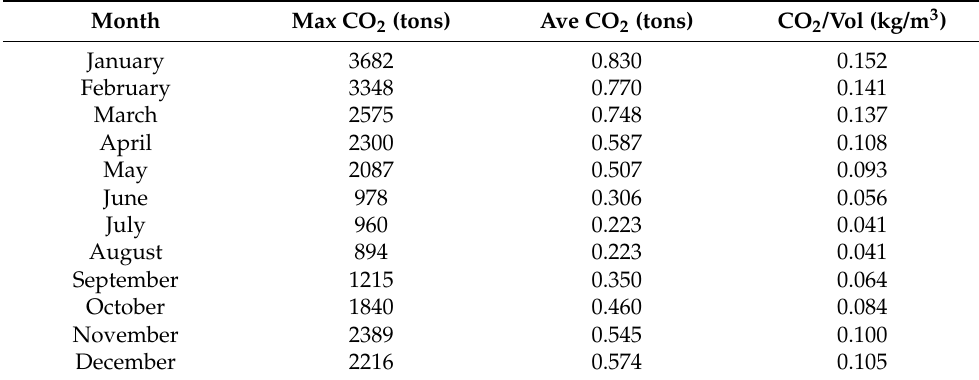
Table 3. National scale metrics of CO 2 emissions from